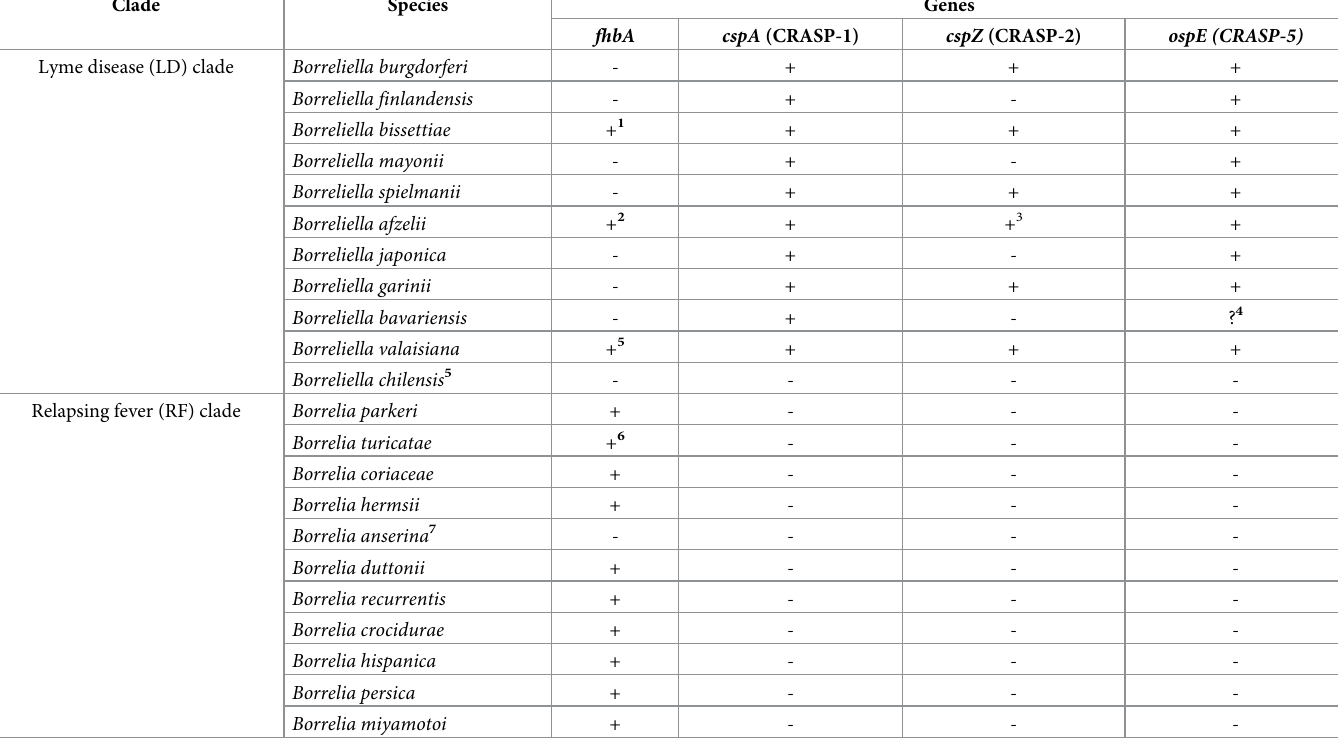
Table 3. fhbA -related, cspA (CRASP-1/BBA68), cspZ (CRASP-2) and ospE genes reported in borreliae . ‘+’ means that the gene has been identified at least in one sour- ce.’–‘means that the sequence was not found in any of the sources used. Data were acquired from the sequenced genomes, published reports and individual sequences deposited to the databases. Relevant genes were searched as described in Materials and Methods. Accession numbers for FhbA-related proteins are listed in the legend to Fig 4. Clade Lyme disease (LD) clade